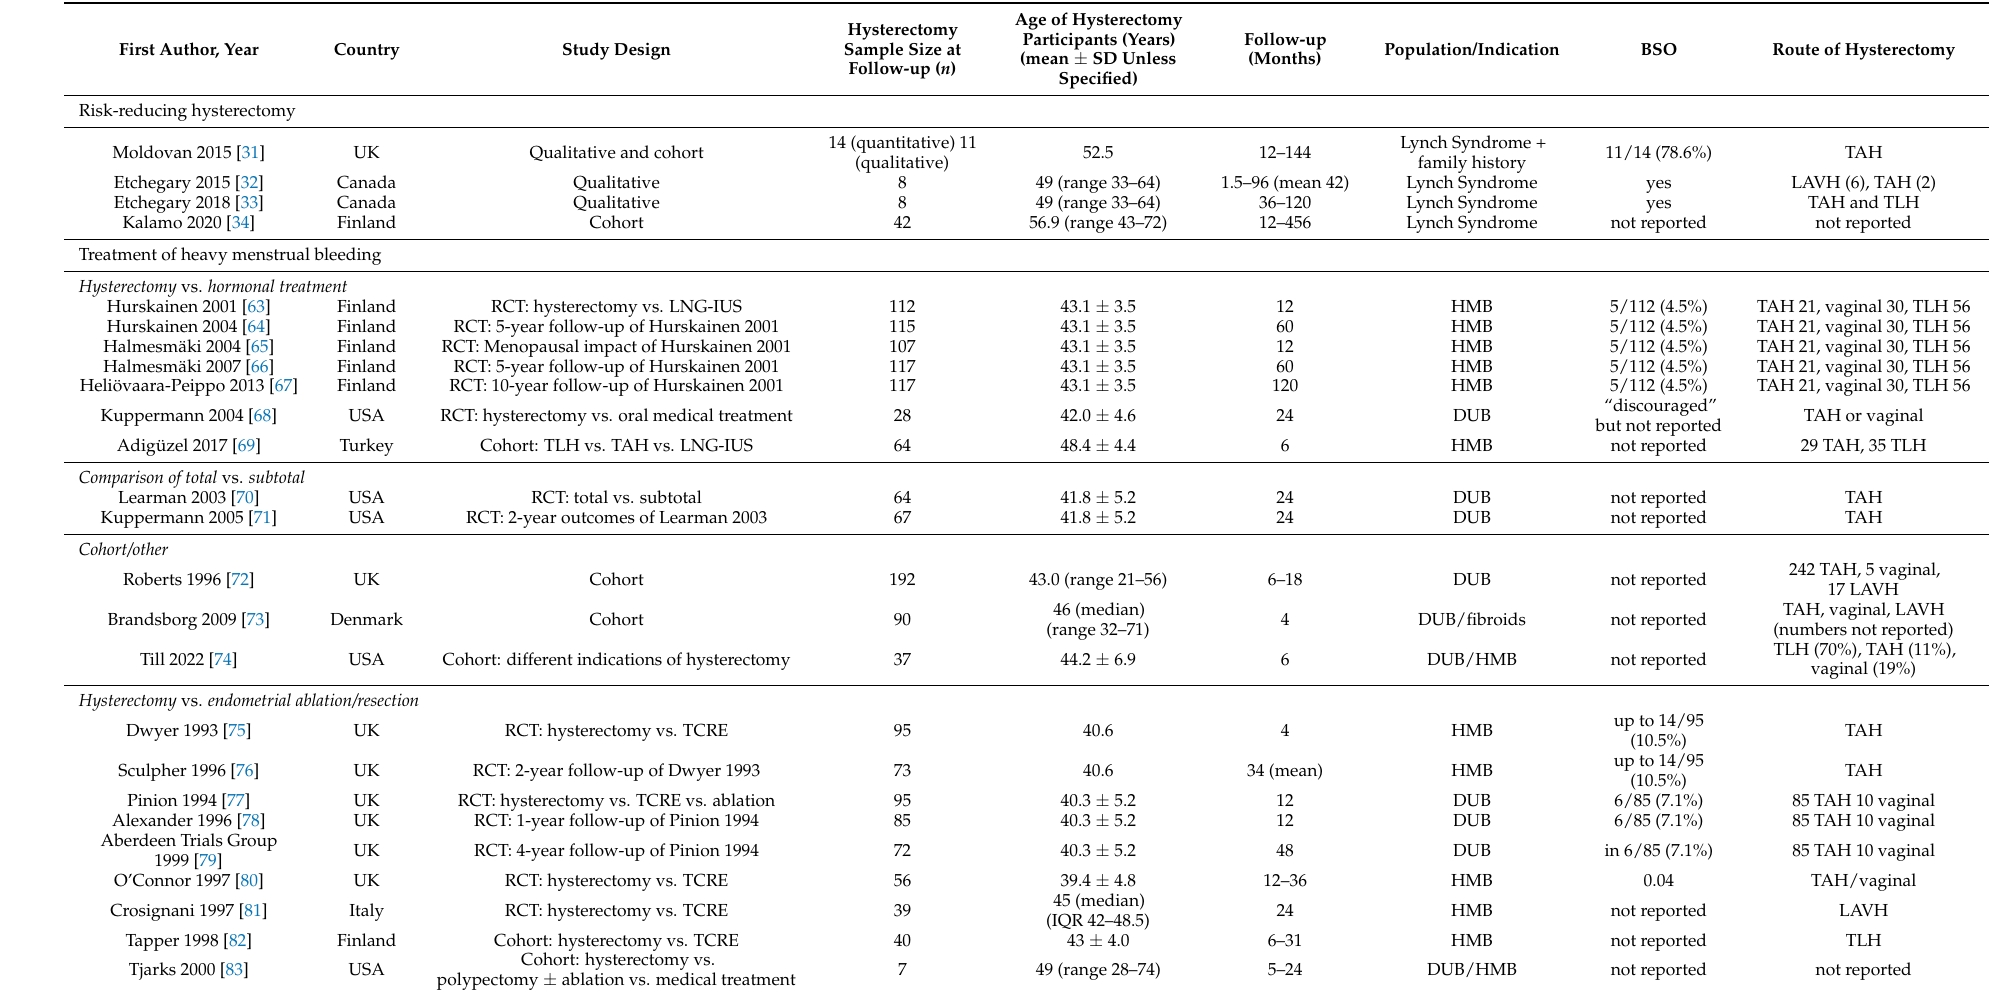
Table 1. Characteristics of included